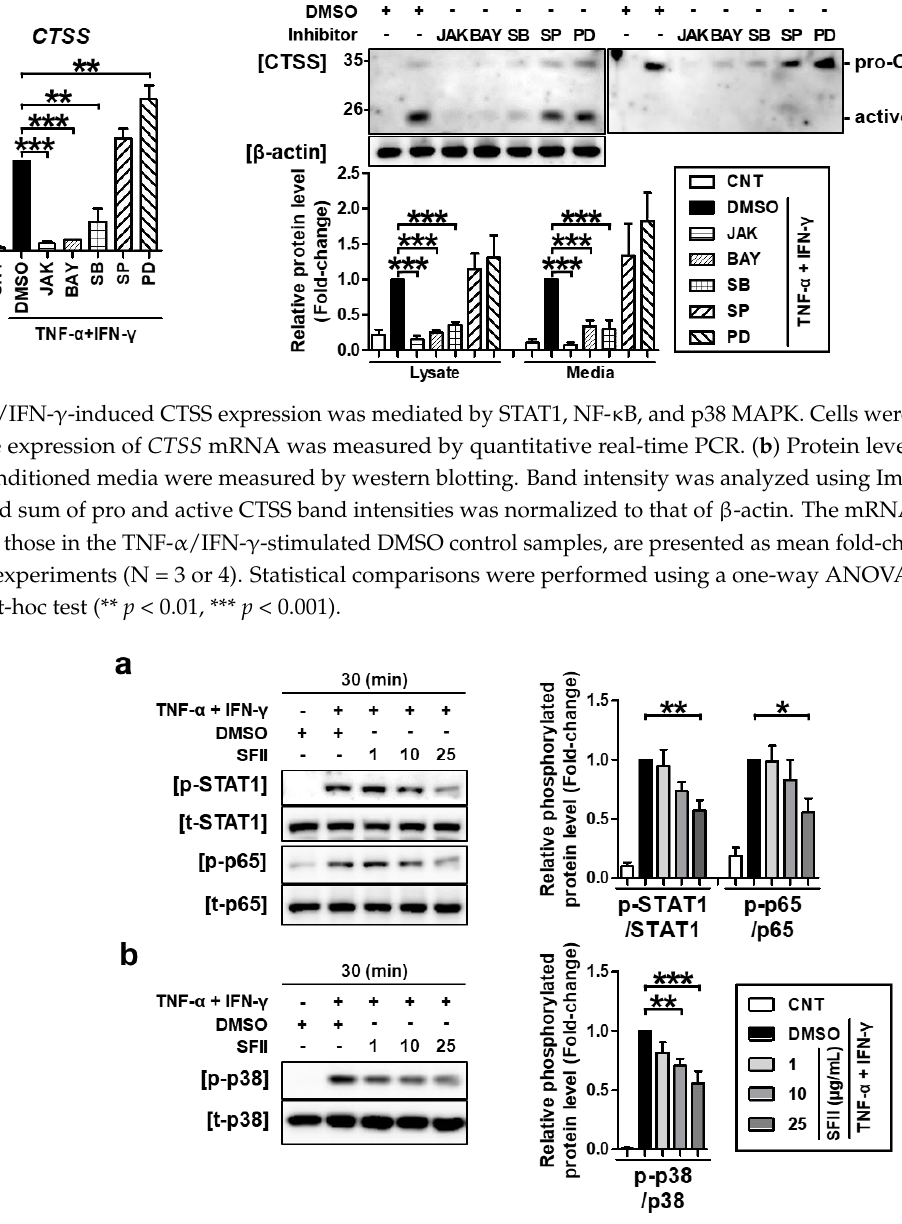
Figure 5. SFII suppressed TNF- α /IFN- γ -induced TARC, MDC, and CTSS by inhibiting STAT1, p65, and p38 MAPK activation. Cells were pretreated with 1, 10, and 25 µ g/mL of SFII or DMSO, 30 min prior to TNF- α /IFN- γ -stimulation, and then, the cell lysate samples were harvested at 30 min after stimulation. Protein levels of ( a ) phosphorylated and total forms of STAT1 (p/t-STAT1), p65 (p/t-p65), and ( b ) p38 (p/t-p38) were measured by western blotting. Band intensity was analyzed using ImageJ software and normalized to the total form of each protein. Relative phosphorylated protein levels, normalized to those in the TNF- α /IFN- γ -stimulated DMSO control sample, are presented as the mean fold-change ± SEM of data (N = 4). Statistical comparisons were performed using a one-way ANOVA followed by Bonferroni’s post-hoc test (* p < 0.05, ** p < 0.01, *** p < 0.001).